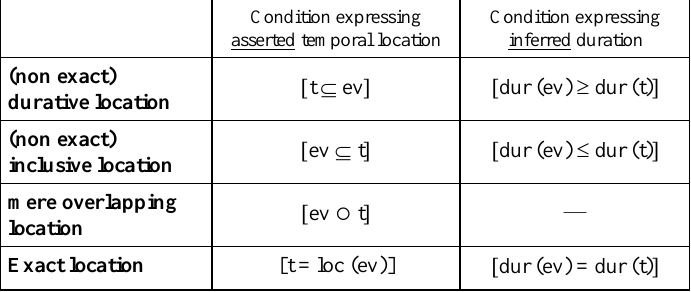
Table 3. Temporal location and inferred